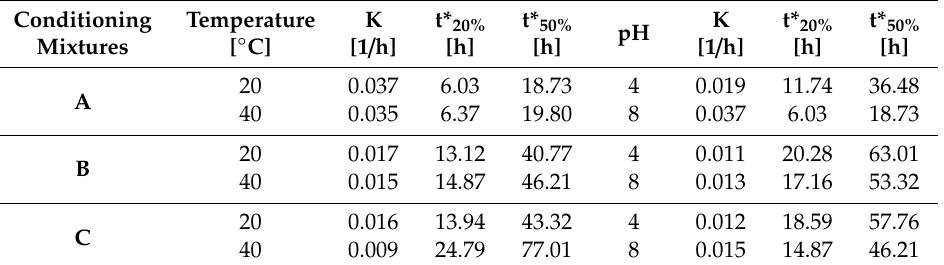
Table 4. Blackman overall first order kinetic constant (K) and estimated time (t*) required to achieve the 20 and 50% of TOC 0 (t* 20% and t* 50% ) at di ff erent temperature values (mixture concentration = 0.10% and pH = 6) and at di ff erent pH values (mixture concentration = 0.10% and T = 30 ◦